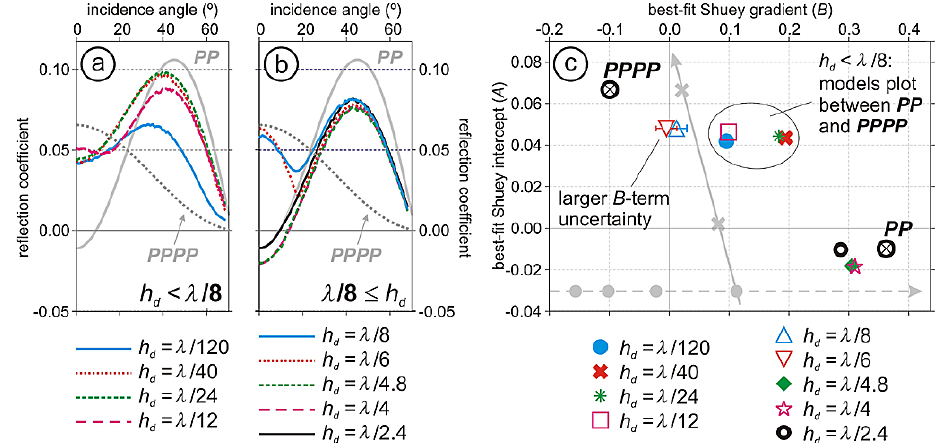
Fig. 5. AVA curves derived from forward-modelled seismic data. (a) Responses for h d < λ /8. (b) Responses for λ/ 8 ≤ h d . Grey curves show effective reflectivities for PP and PPPP, with an obliquity factor applied, for reference. (c) AVA cross-plot for reflectivities in (a) and (b) . For reference, the example models from Fig. 1c are also plotted (light